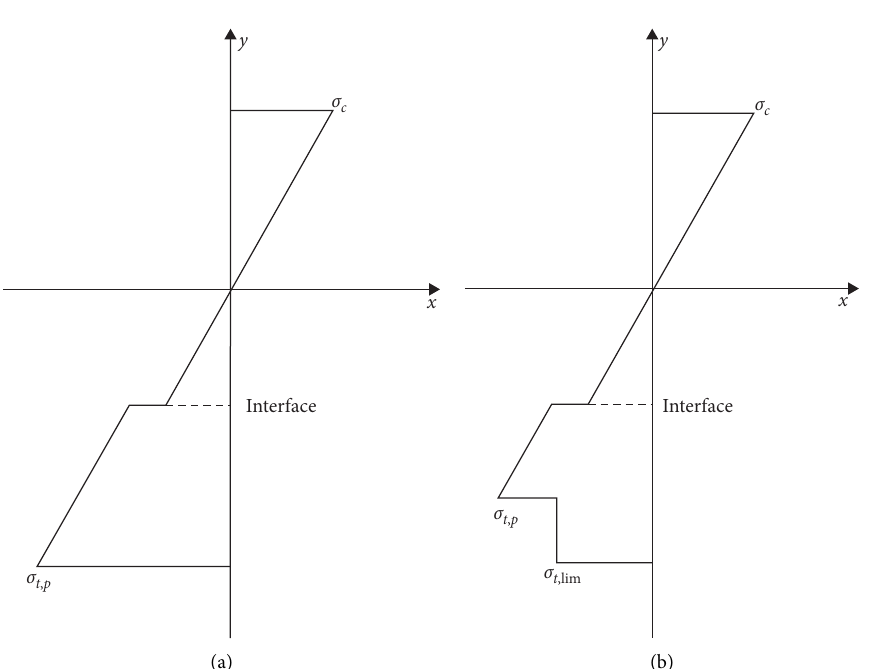
Figure 20: Stress distribution for the flexural section. (a) Stress distribution for cracking loading. (b) Stress distribution for ultimate